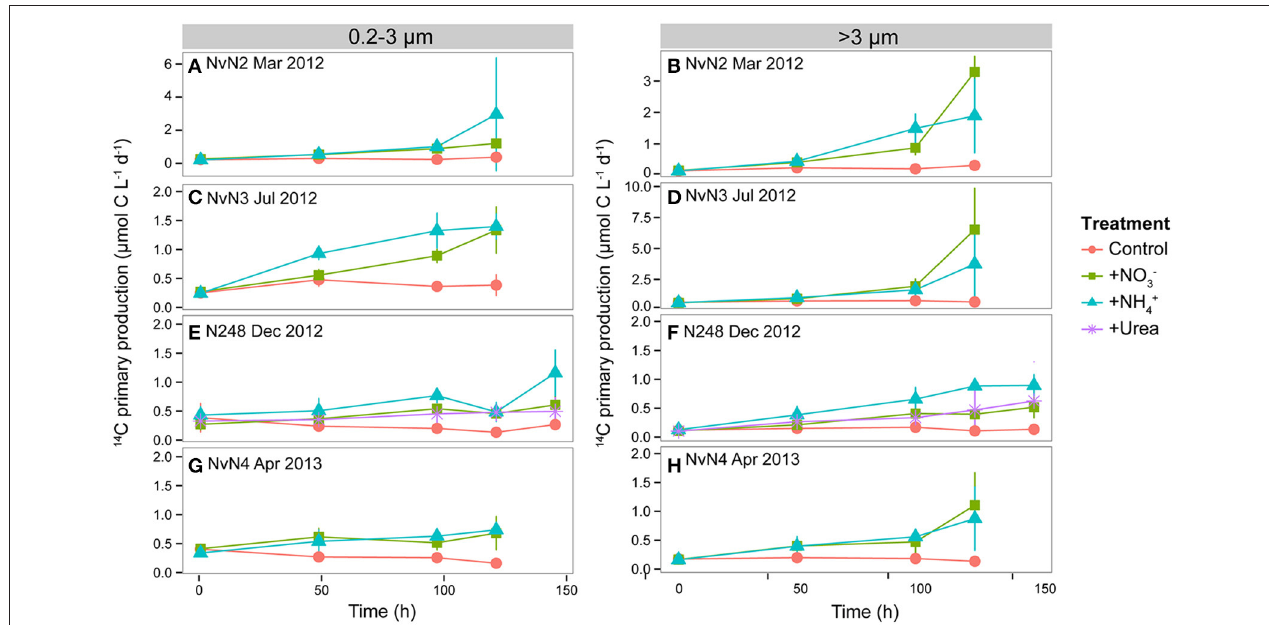
FIGURE 2 | Time dependence in rates of 14 C-primary production ( µ mol C m − 3 d − 1 ) by pico- (0.2–3 µ m) and larger ( > 3 µ m) phytoplankton during experiments conducted in (A,B) March 2012, (C,D) July 2012, (E,F) December 2012, and (G,H) April 2013. Colors of lines indicate different treatments: Control, + NO − 3 , + NH + 4 , and + Urea. Data points and whiskers indicate means and standard deviations of triplicate carboys. Note differences in y-axis scales for (A,B,D)